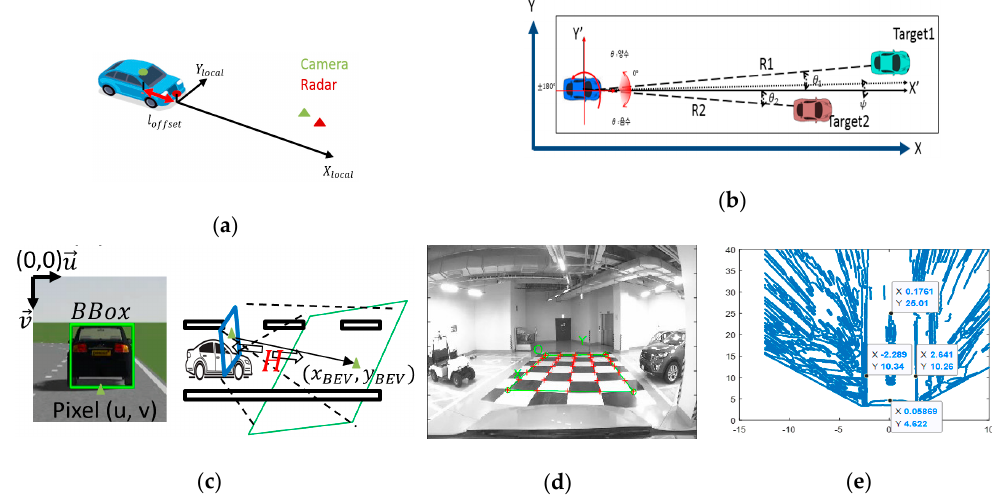
Figure 2. Multi-sensor coordination alignment process: ( a ) multi-sensor coordinate matching, ( b ) radar coordinates, ( c ) transformation of image frame to top-view frame, ( d ) camera calibration, ( e ) transformation into vehicle coordinates.